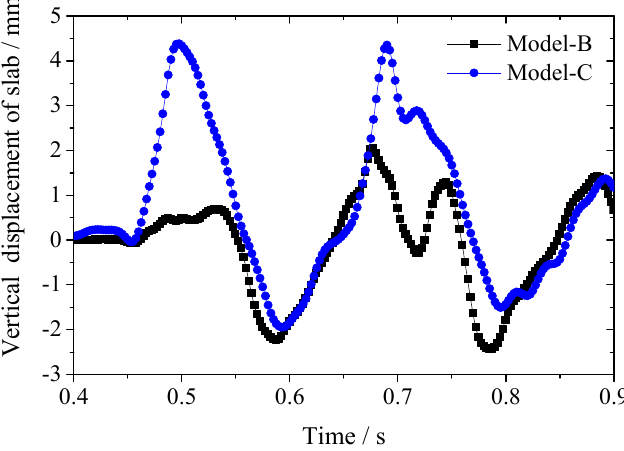
Figure 14. Time history of vertical displacement of track slab with Model-B and Model-C.